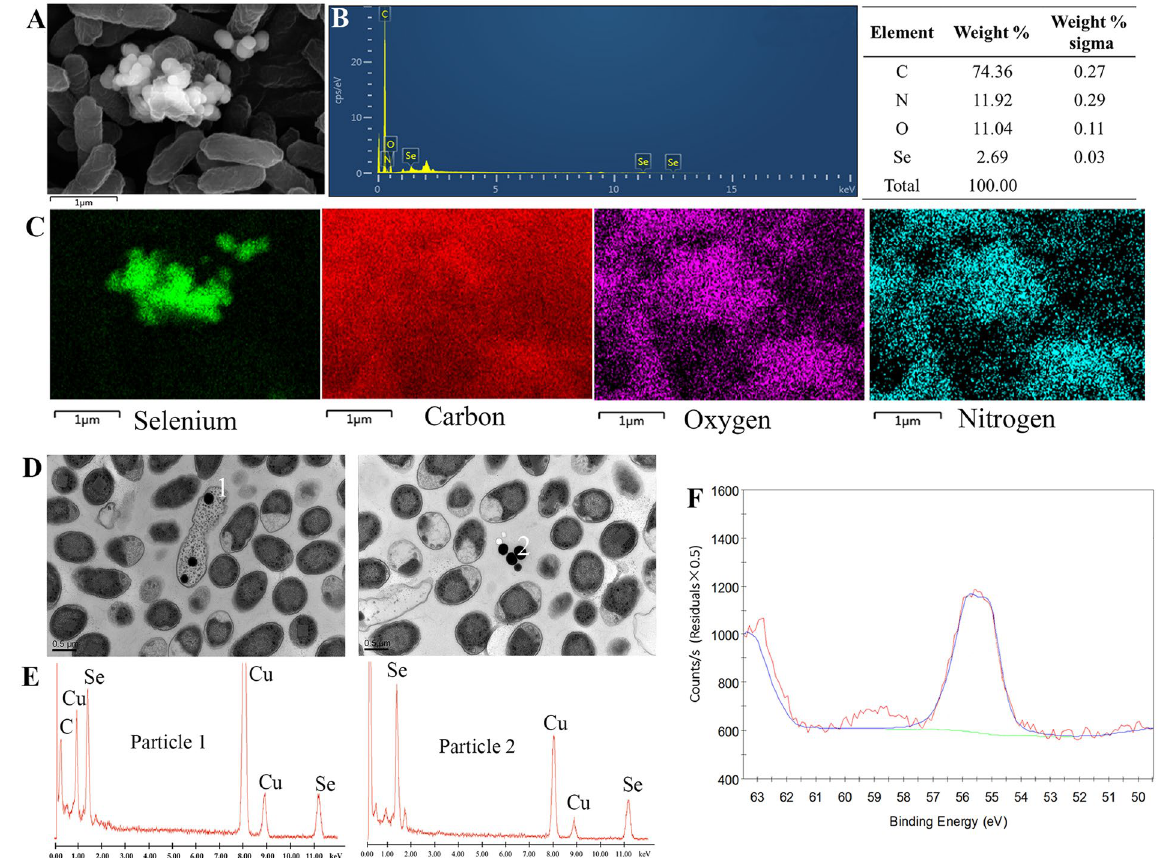
of ( A ). ( C ) Elemental mapping analysis of the distribution of selenium, carbon, oxygen and nitrogen in the area of ( A ). ( D ) TEM images of E. cloacae Z0206 and SeNPs. ( E ) EDX analysis of particle 1 and 2 in ( D ). ( F ) High- resolution Se 3D XPS of purified SeNPs synthesized by E. cloacae